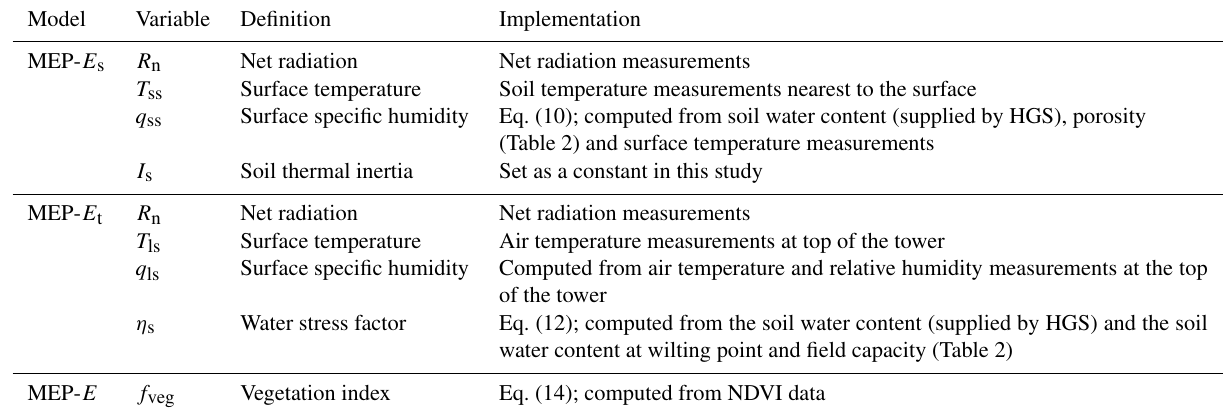
Table 3. Implementation of the MEP model of total terrestrial evaporation in this study. Model Variable Definition Implementation Net radiation measurements Soil temperature measurements nearest to the surface Eq. (10); computed from soil water content (supplied by HGS), porosity (Table 2) and surface temperature measurements Set as a constant in this study Net radiation measurements Air temperature measurements at top of the tower Surface specific humidity Computed from air temperature and relative humidity measurements at the top of the tower Water stress factor Eq. (12); computed from the soil water content (supplied by HGS) and the soil water content at wilting point and field capacity (Table